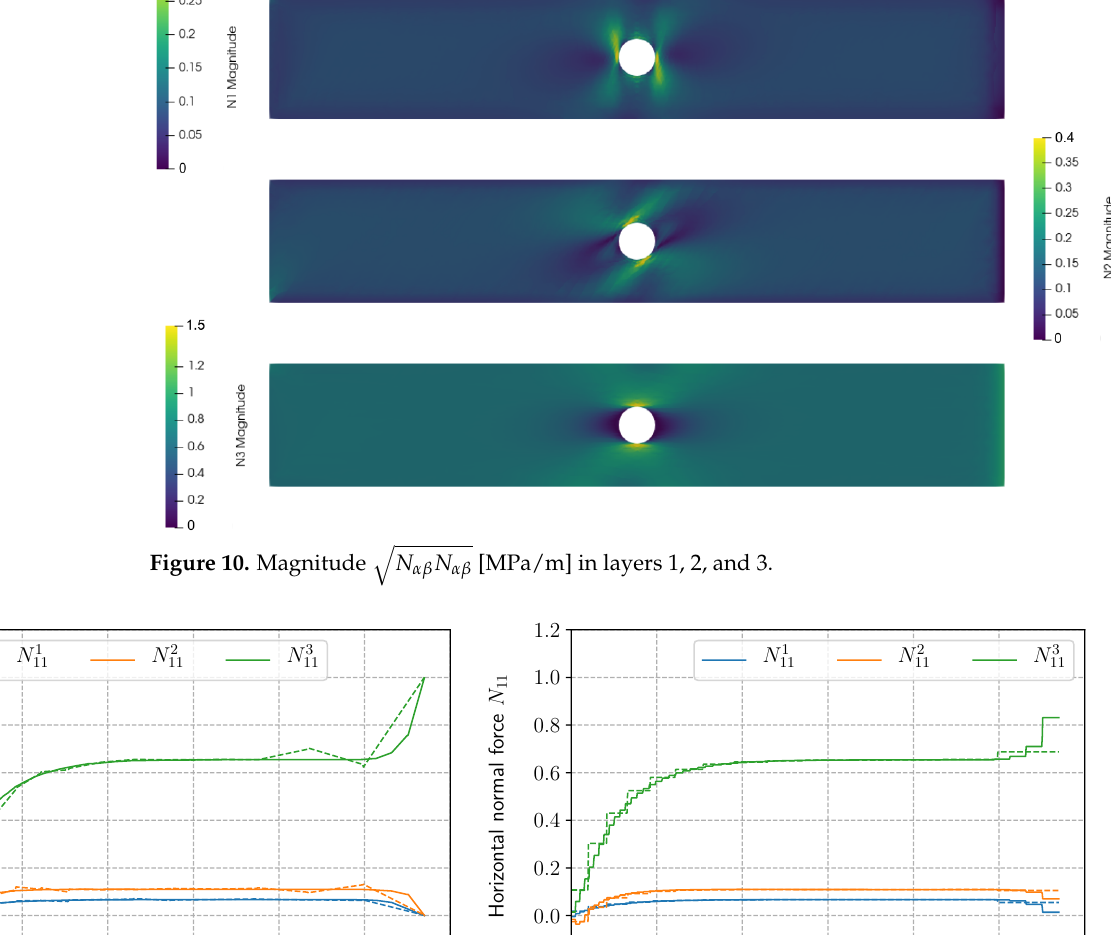
Figure 11. Evolution of N 11 [MPa/m] along the plate length for a coarse (dotted line) and a fine (solid line) mesh. ( a ) N 11 with the mixed ( p = 2) approach; ( b ) N 11 with the displacement